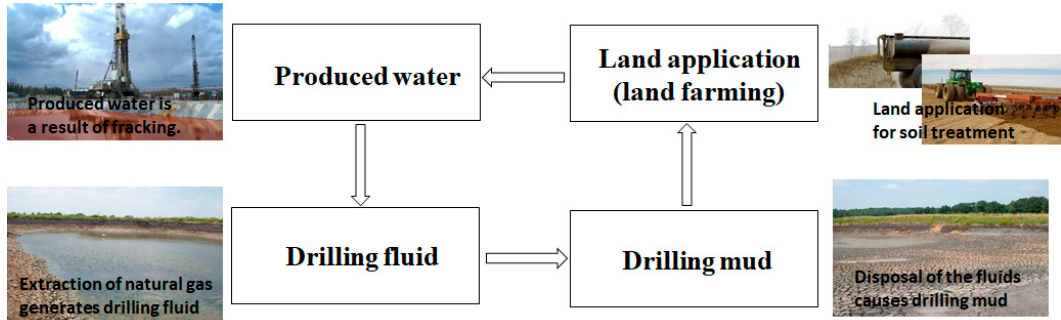
Figure 11. The diagram for drilling fluid and land affections